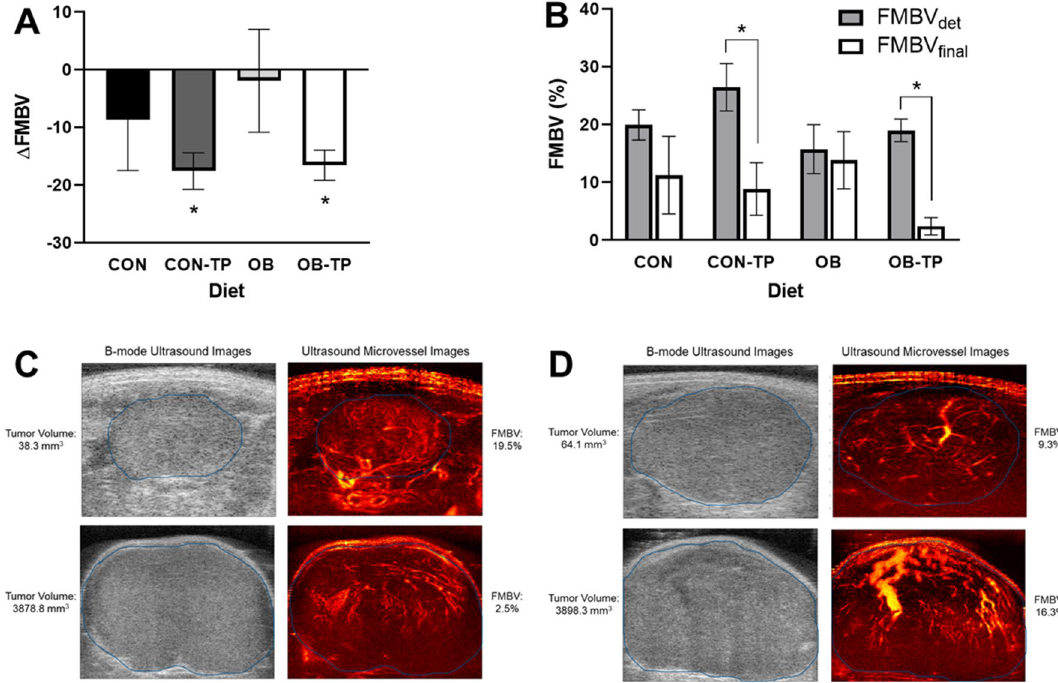
Figure 3. ( A ) Fractional moving blood volume (FMBV) overall changes (ΔFMBV) and ( B ) FMBV changes over time by dietary group show TP led to reduced tumor blood perfusion. Representative images depicting ( C ) decreasing FMBV and ( D ) increasing FMBV over time (between tumor detection and final tumor scan). Tumors are bordered in blue. *Indicates statistical significance ( p < 0.05 by paired t-test FMBV, n = 5/dietary group).